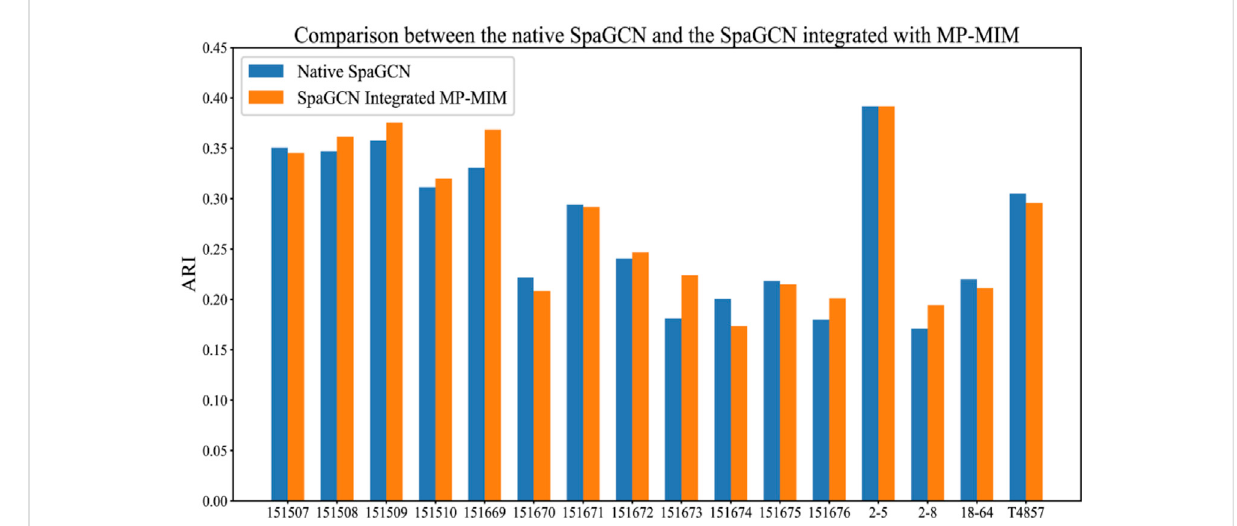
FIGURE 6 Comparison between the original SpaGCN and the SpaGCN integrated with MP-MIM. The results of the original SpaGCN are obtained by keepingallhyperparametersofSpaGCNasdefault,andSpaGCNintegratedwithMP-MIMshowstheresultsafterintegratingMP-MIMintotheoriginal SpaGCN.